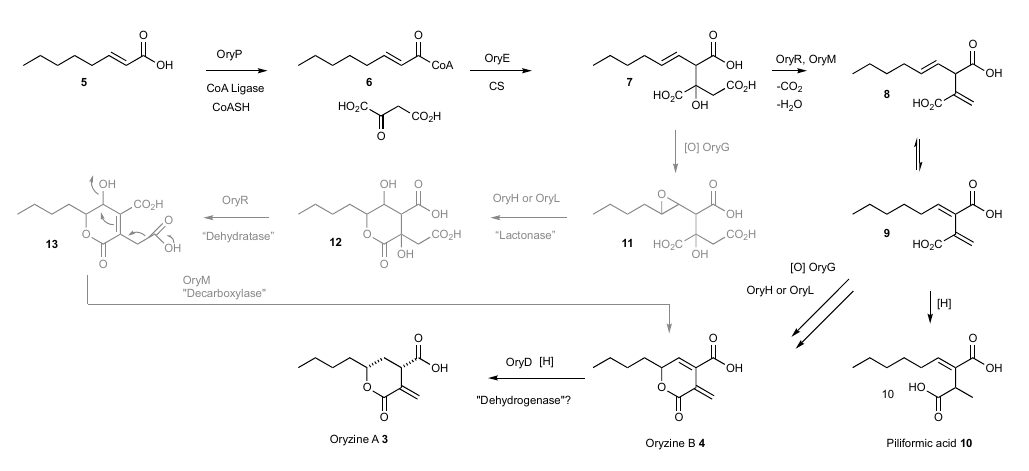
Figure 4. Proposed biosynthetic pathway for oryzine A 3 and B 4 .